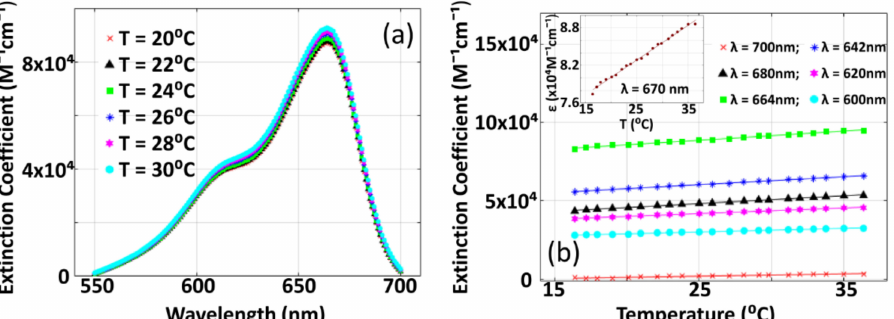
Figure 6. Variation of extinction coefficient ( a ) with respect to optical wavelength ( λ ) (at various thermodynamic temperature ( T )). ( b ) Variation of optical extinction coefficient ( ε ) against ( T ) for different λ . Inset in ( b ) presents variation of ε against T for λ = 670 nm, which is the optical wavelength of pulsed laser beam used for imaging (in our present study). In the experiments, we used methylene blue solution with [ C ] ∼ 2 µ